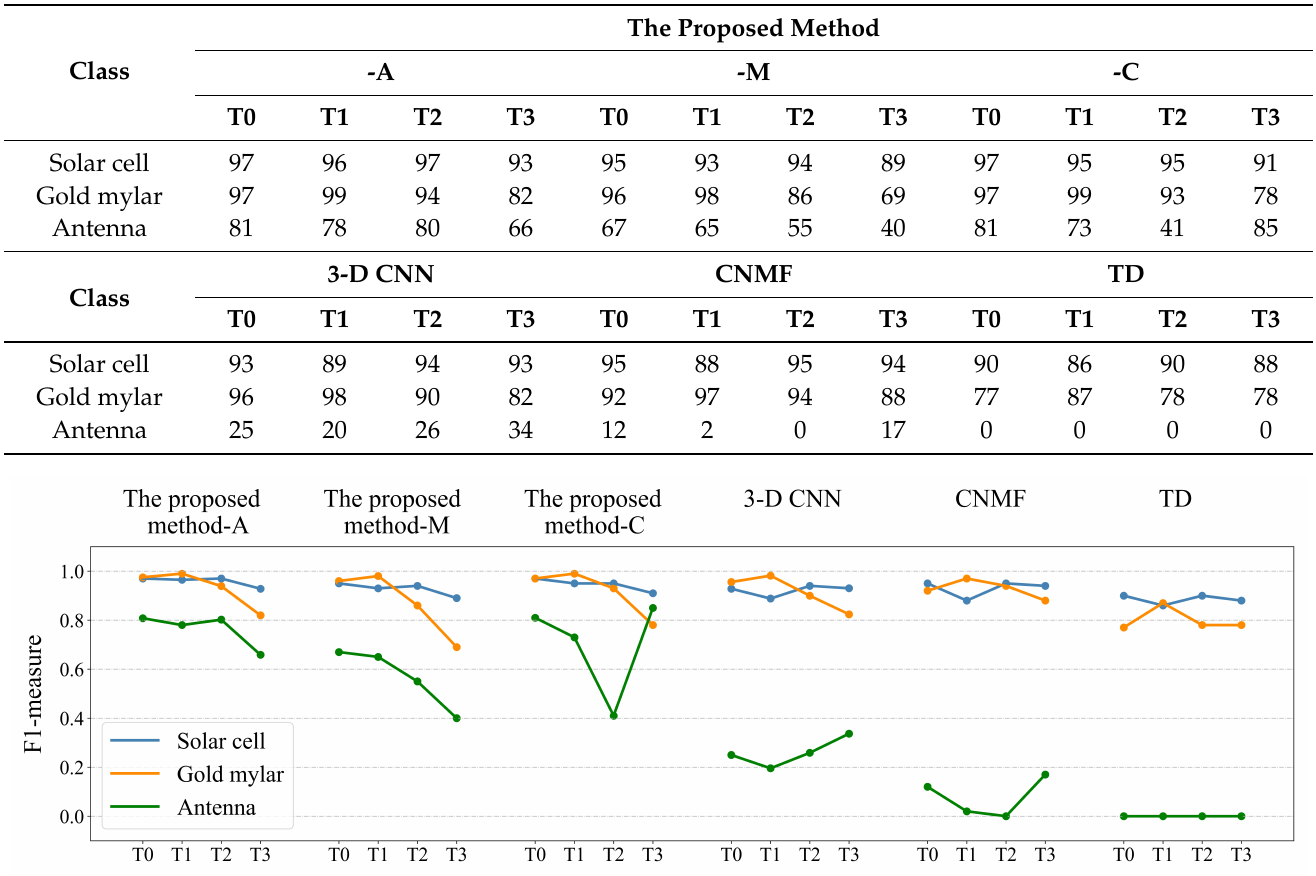
Table 3. F1-measure (%) table of the simulated data.